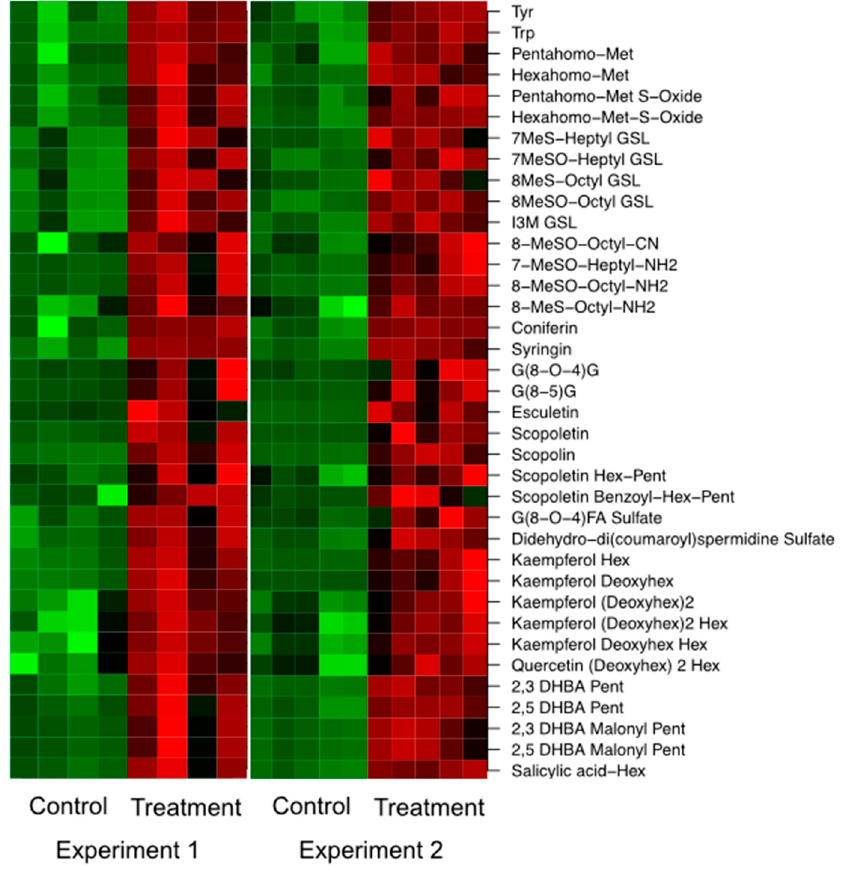
Figure 8. Differentially expressed secondary metabolites occurring in root extracts of A. thaliana across two independent biological experiments. Candidates were retrieved from a two-sided t -test ( p < 0.01). For visualization, intensity values were log-transformed and z-scored row-wise. Red: maximal intensity; green: minimal intensity.